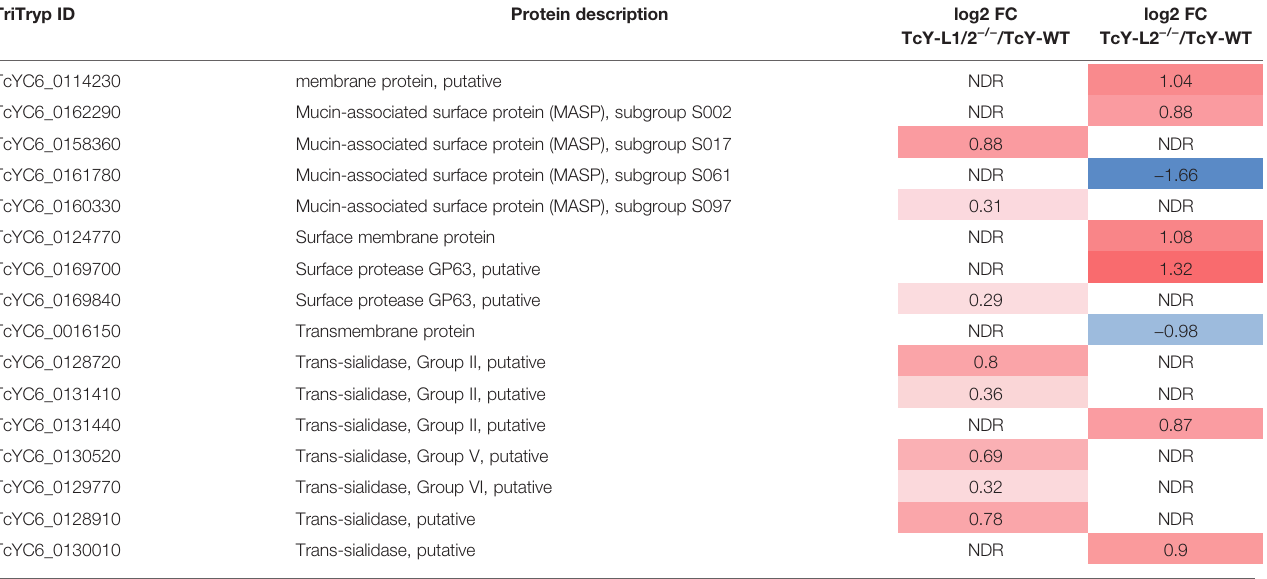
TABLE 2 | Important surface membrane proteins regulated in TcY-L1/2 − / − and TcY-L2 − / − trypomastigotes compared to TcY-WT trypomastigotes. TriTryp